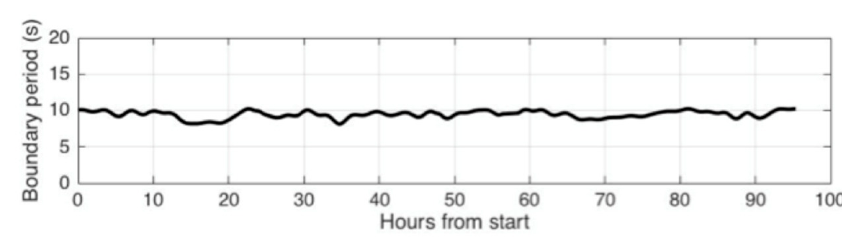
Figure 10. The boundary period plotted vs. time. Start time: 12:00 a.m., 12 March 2015. Figure 11 shows the measured spectral wave parameters obtained from the radar at Espichel, Portugal and from Lisbon buoy wave data.